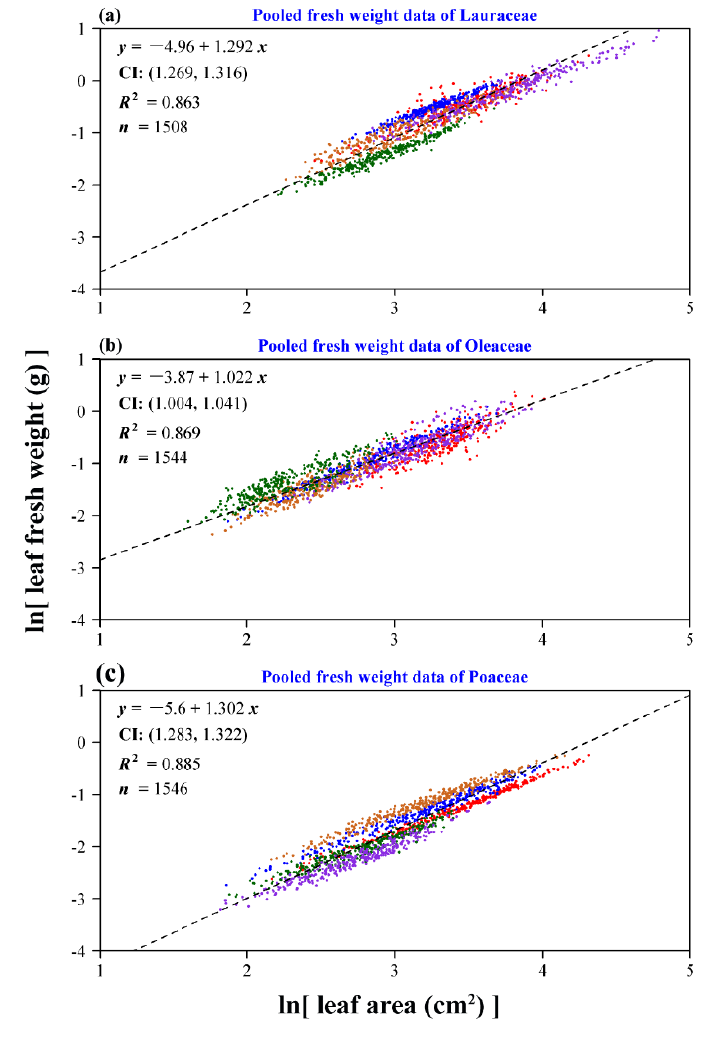
Figure 7. Scaling relationship of leaf fresh weight to leaf area for the pooled data of every family: ( a ) Lauraceae; ( b ) Oleaceae; ( c ) Poaceae. In each panel, the colored points represent the observations, and the black dashed line represents the reduced major axis regression line. Furthermore, y represents the natural logarithm of leaf fresh weight in g, x represents the natural logarithm of leaf area in cm 2 , CI represents the 95% confidence interval of the slope, R 2 is the coefficient of determination used to measure the goodness of fit, and n represents the total number of leaves sampled for the species of the same family. Different colored points represent different species in each panel, but the same colors in different panels do not represent the same species.